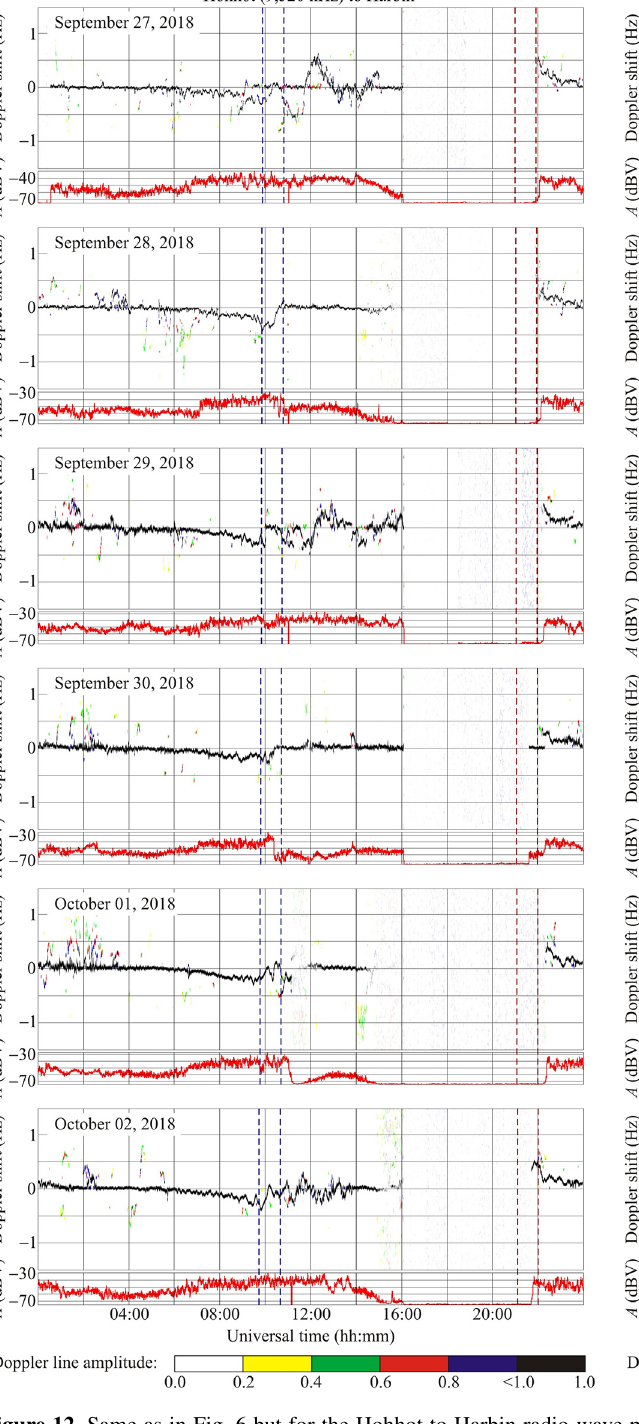
Figure 12. Same as in Fig. 6 but for the Hohhot to Harbin radio-wave propagation path at 9520kHz for the 27 September–2 October and 3–8 October 2018